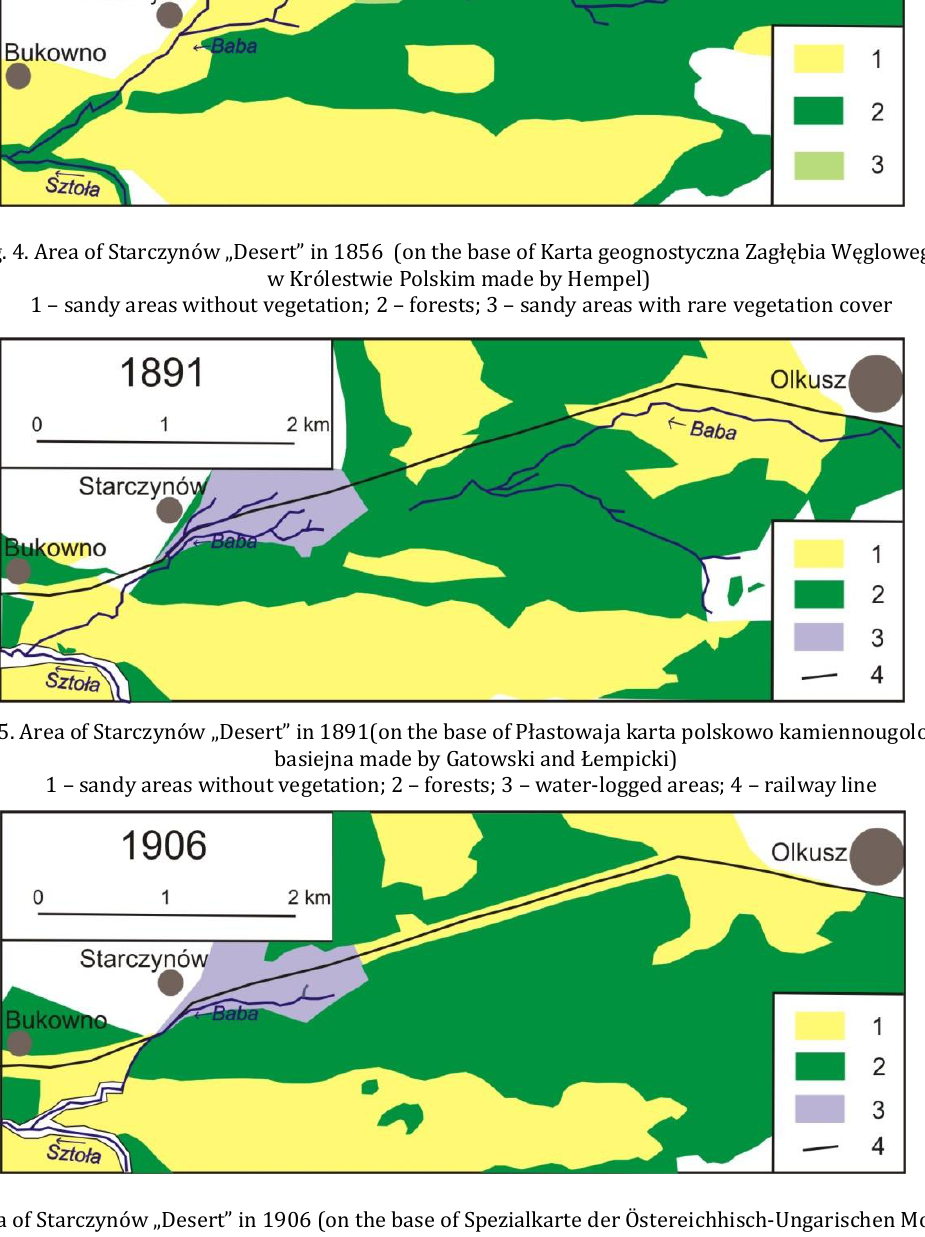
Fig 6. Area of Starczynów „Desert” in 1906 (on the base of Spezialkarte der Östereichhisch-Ungarischen Monarchie) 1 – sandy areas without vegetation; 2 – forests; 3 – water-logged areas; 4 – railway